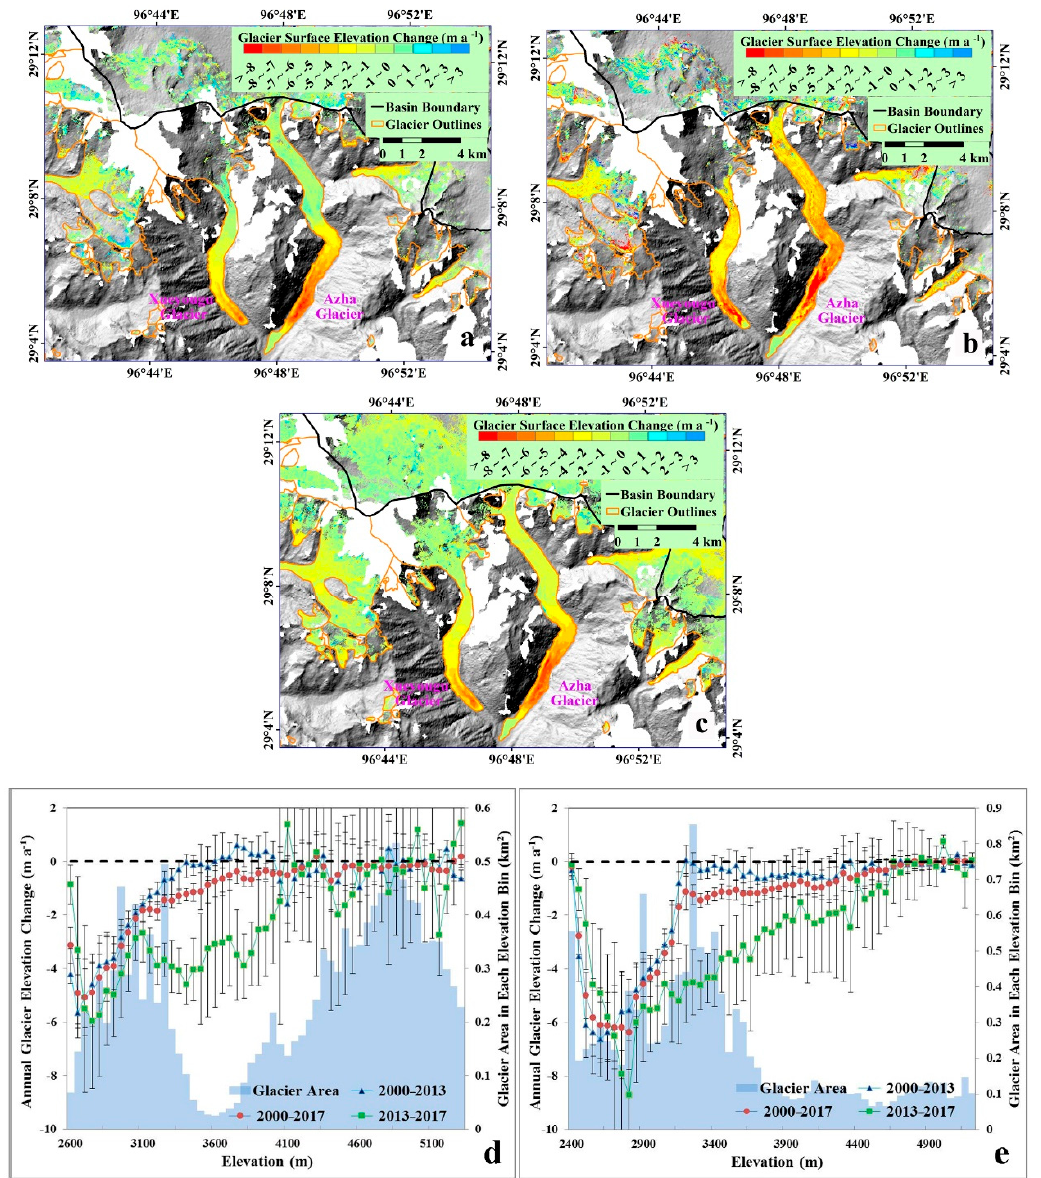
Figure 11. Annual elevation changes of the Xueyougu glacier and the Azha glacier (the purple rectangle region in Figure 10). ( a ): 2000–2013; ( b ): 2013–2017; ( c ): 2000–2017; ( d ) and ( e ): annual glacier elevation changes of the Xueyougu glacier ( d ) and the Azha glacier ( e ) versus elevation.